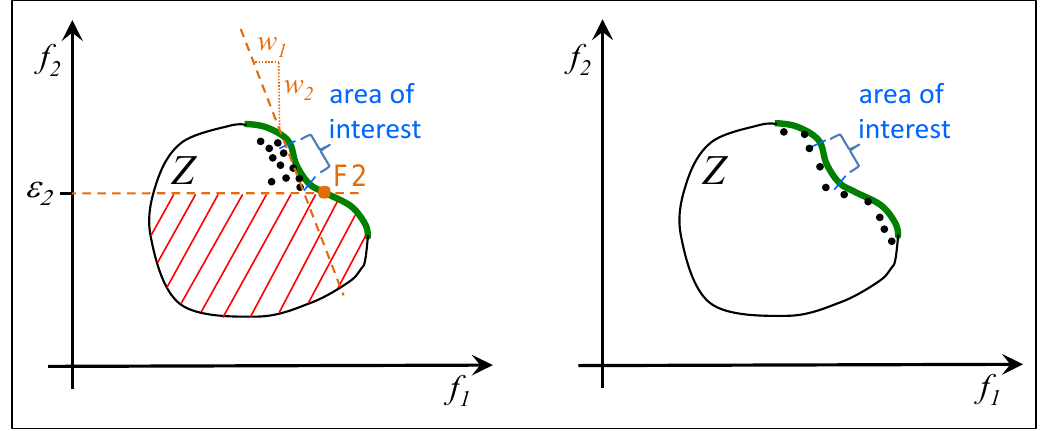
Figure 10. Both diagrams show a sample population of an advanced search more or less shortly before convergence. The CWS concentrates the best individuals ( black dots ) more or less on the region of interest, as shown in the left diagram. In contrast to that, Pareto-based optimization procedures attempt to distribute their solutions along the Pareto front as best as they can, see the right diagram. Thus, fewer solutions will be found in the area of